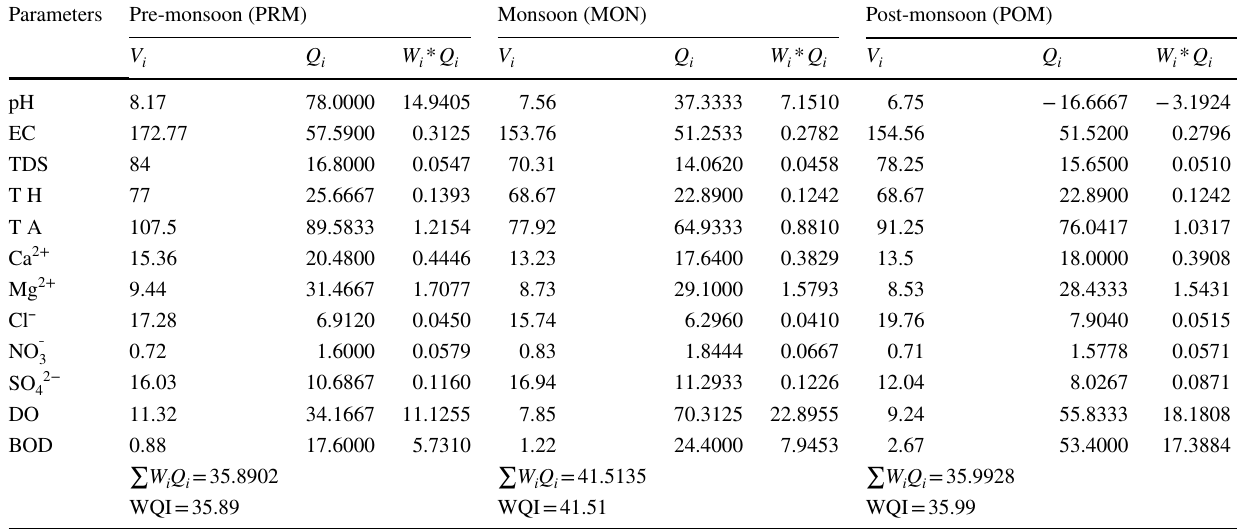
Table 10 Calculation of WQI at station 6 (S 6) Parameters